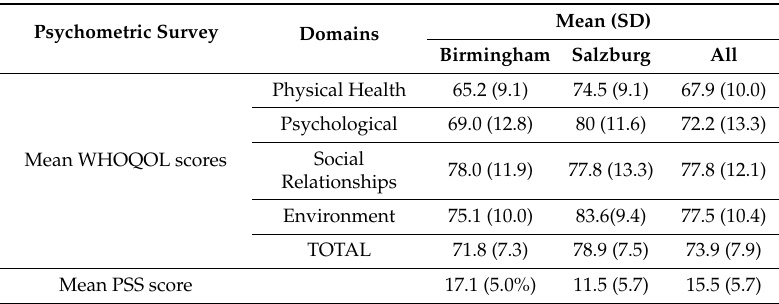
Table 2. Psychometric survey results.